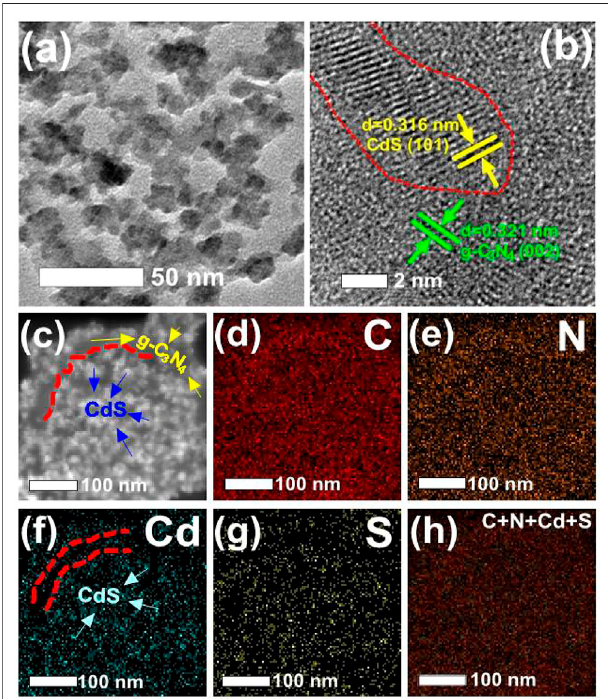
FIGURE 2 | (A) TEM, (B) HRTEM, and (C) HAADF-STEM images of g-C 3 N 4 /CdS-2 hybrids. (D – G) Elemental mappings of(d) C, (e) N, (f) Cd, (g) S, and (h) C + N + Cd + S of g-C 3 N 4 /CdS-2